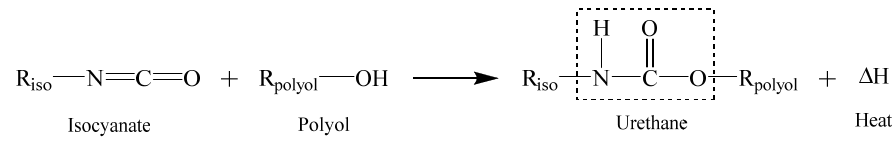
Scheme 1 . Reaction scheme of urethane production [10].